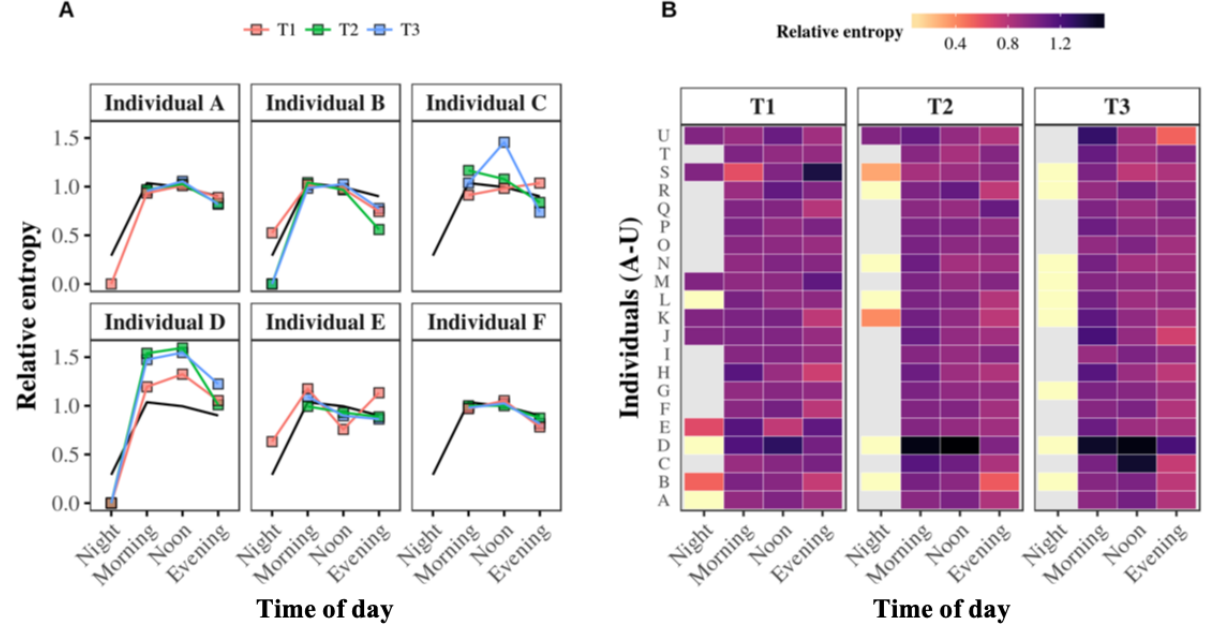
Figure 5. Relative entropy values at the individual level. Panel A. The relative entropy values of the same 6 individuals described in Figure 2 for the night, morning, afternoon, and evening are calculated for the first, second, and third 4-month periods: T1 (red curve), T2 (green curve), and T3 (blue curve), respectively. The black curve represents the whole population’s average relative entropy value over the three periods. Panel B. The heat map summarizes all the relative entropy values of all 21 egos. The lower or higher the relative entropy, the brighter or darker the color assigned to it, respectively. Missing values are assigned a grey